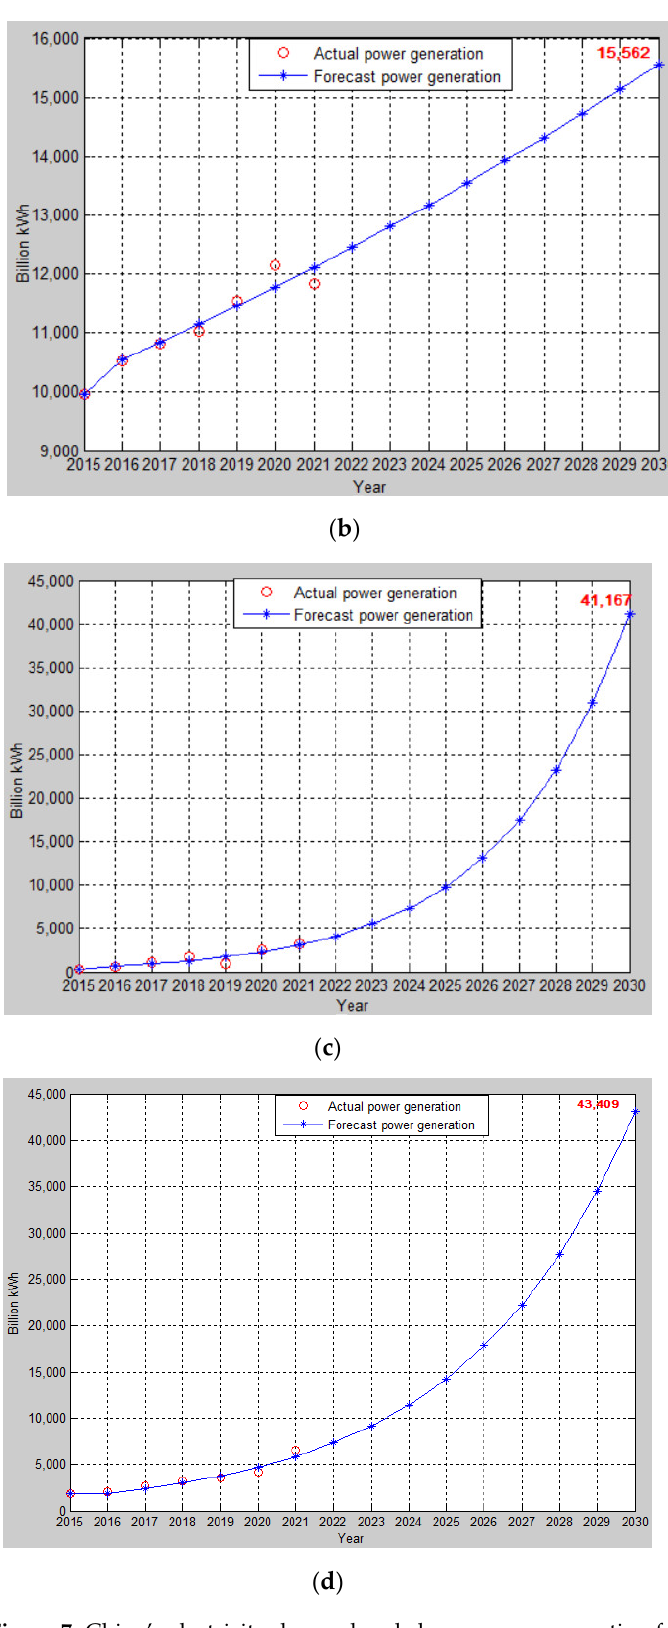
Figure 7. China’s electricity demand and clean energy generation forecast. ( a ) Electricity demand forecast, ( b ) hydropower forecast, ( c ) PV power forecast, ( d ) wind power forecast.